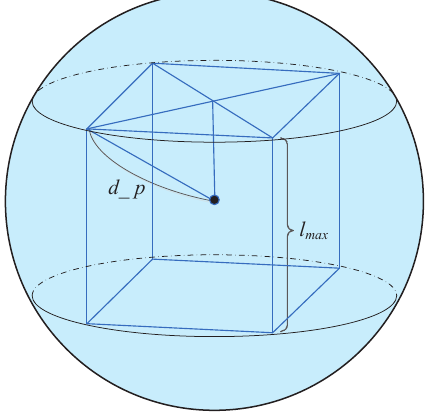
Figure 2. Grid size calculation in